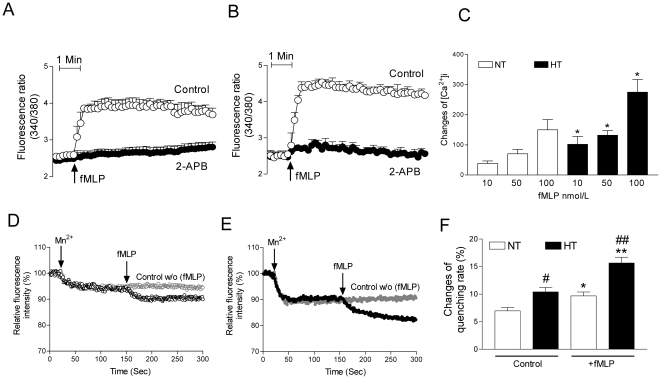
Increased fMLP-induced changes of cytosolic calcium in monocytes from patients with essential hypertension.
A, B; Representative fluorescence tracings in monocytes from normotensive control subjects (A) and hypertensive patients (B) after administration of fMLP (100 nm/L) in the absence and presence of TRP channel-inhibitor 2-APB. C; Summary data of changes of intracellular calcium concentration in monocytes from normotensive control subjects (NT; open bars) and patients with essential hypertension (HT; filled bars) by several doses of fMLP (10 nmol/L, 50 nmol/L, and 100 nm/L). Each n = 10; *p<0.05 for the comparison HT vs. NT. D, E; fMLP-induced cation influx into monocytes indicated by quenching of fura-2 by manganese (Mn2+, 1 µmol/L). Representative raw data, showing mamganese quenching with a stimulus (fMLP, 100 nmol/L) or without stimulus (control, w/o fMLP) in monocytes from normotensive control subjects (D; open black or grey circle; NT) and patients with essential hypertension (E; filled black or grey circle; HT). F; Bar graph shows the summary data of manganese quenching rate obtained from normotensive control subjects (NT, n = 6) and patients with essential hypertension (HT, n = 8) under the control conditions or after administration of fMLP (100 nmol/L). *p<0.05 or **p<0.01 for the comparison with their controls; and #p<0.05 or ## p<0.01 for the comparison HT (filled bars) vs. NT (open bars).